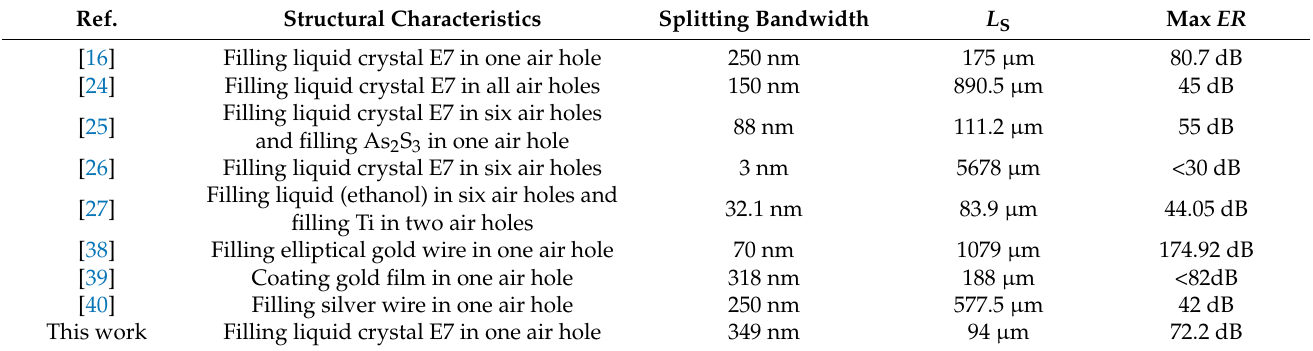
Table 1. Comparisons between the proposed LC-DC-PCF PBS and reported DC-PCF PBS.